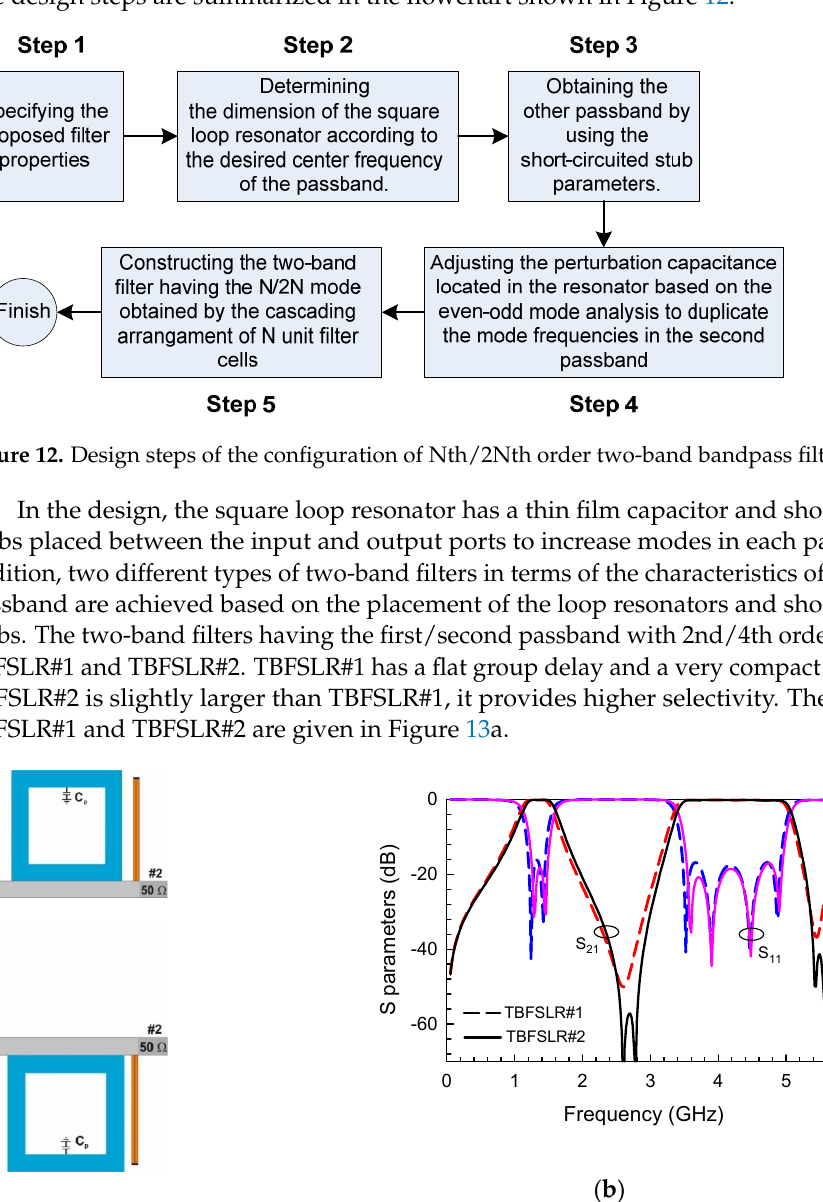
Figure 13. The configuration of the ( a ) TBFSLR#1 and TBFSLR#2, ( b ) Comparison of the simulated frequency responses.